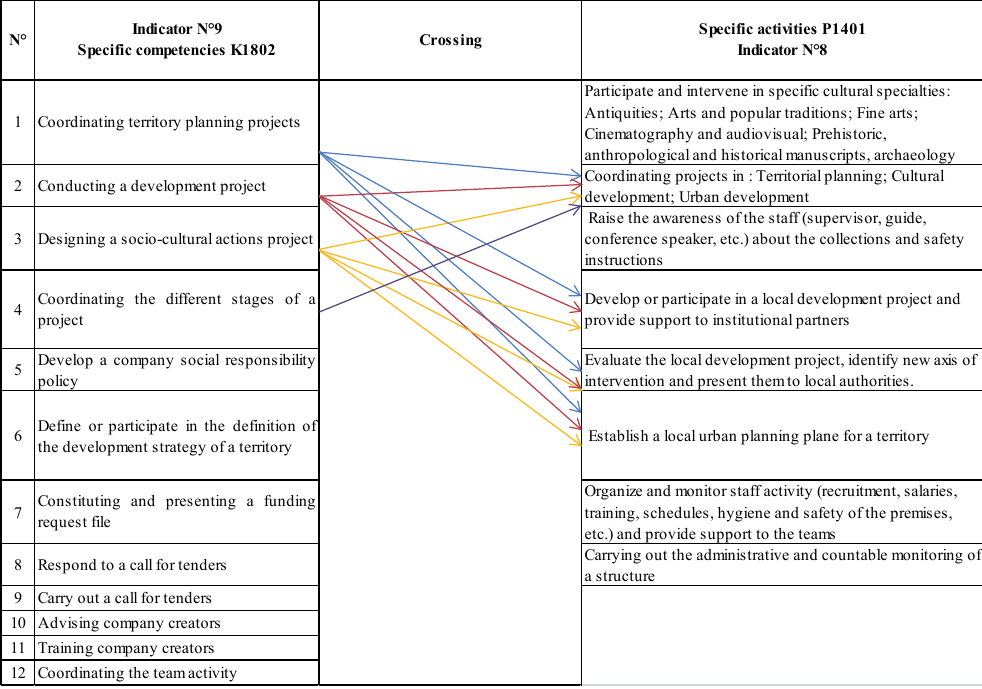
Table 7. Crossing Indicator No. 9 K1802 with Indicator No.8